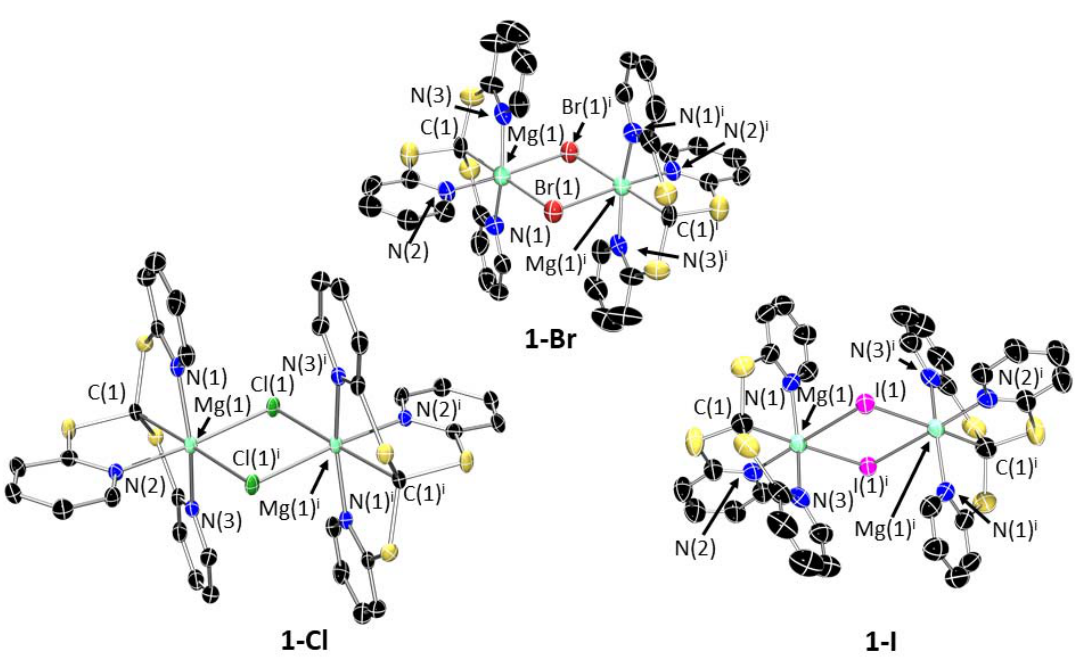
Figure 3. X-ray crystal structures of 1-X (X = Cl, Br, I). Ellipsoids are set at 50% probability level, and hydrogen atoms and lattice solvent molecules have been excluded for clarity. The figures have been reproduced as dimers to fully illustrate the geometry. C: black; N: blue; S: yellow; Mg: aquamarine; Cl: green; Br: brown; I: purple. 1-Cl : The asymmetric unit contains one monomer and half a molecule of benzene. Symmetry operation used to generate equivalent atoms: i = –x, 0.5 + y, 0.5 − z. Selected bond lengths (Å) and angles (°): Mg(1)–C(1) 2.427(11), Mg(1)–N(1) 2.186(11), Mg(1)–N(2) 2.204(10), Mg(1)–N(3) 2.193(11), Mg(1)–Cl(1) 2.427(5), N(1)–Mg(1)-N(2) 87.1(4), N(2)-Mg(1)-N(3) 94.1(4), C(1)- Mg(1)-Cl(1) 178.9(4). 1-Br : The asymmetric unit contains two monomers. Symmetry operation used to generate equivalent atoms: i = 1 − x, 2 − y, 1 − z. Selected bond lengths (Å) and angles (°): Mg(1)- C(1) 2.231(11), Mg(1)-N(1) 2.219(9), Mg(1)-N(2) 2.155(9), Mg(1)–N(3) 2.182(9), Mg(1)–Br(1) 2.821(4), N(1)–Mg(1)–N(2) 92.9(3), N(2)–Mg(1)–N(3) 92.1(3), C(1)–Mg(1)–Br(1) 94.2(3). 1-I : Symmetry operation used to generate equivalent atoms: i = 2 − x, 1 − y, 1 − z. Selected bond lengths (Å) and angles (°): Mg(1)–C(1) 2.231(10), Mg(1)-N(1) 2.182(8), Mg(1)–N(2) 2.177(8), Mg(1)–N(3) 2.177(8),